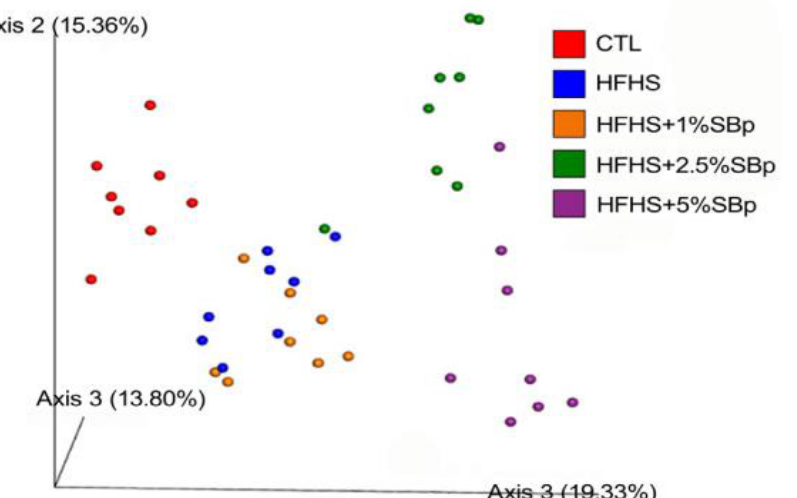
Figure 5. Effect of HFHS diet supplemented with SBp on ß-diversity of gut microbiota in mice. The experimental regimen is described in in the legend of Figure 4. Principle component analysis was based on Bray–Curtis dissimilarities between all sample sets (weighted by taxon abundance). 3.4. Effect of Supplementation with Various Dosages of SBp on Phylum Bacteria in Mice The dominant phylum bacteria in the feces of mice fed various diets are Bacteroidetes and Firmicutes (Figure 6A). The relative abundances of Bacteroidetes in the control group mice receiving low fat diet was significantly higher than that in mice treated with HFHS diet ( p < 0.01). In the group of mice treated with 5% SBp, the abundance of Bacteroidetes were significantly higher than that in mice receiving HFHS diet or HFHS + 1% SBp ( p < 0.05, Figure 6B). The abundances of other phylum bacteria were not significantly different between groups.